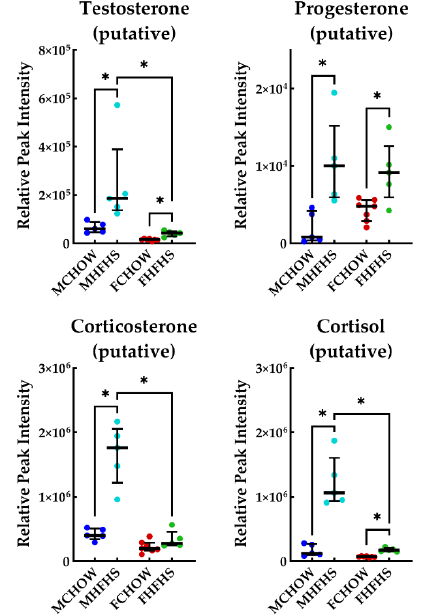
Figure 5. Androgen and Steroid Hormone Related Metabolites. Horizontal bars represent the median relative peak intensity of each metabolite with the interquartile range. * p < 0.01. MCHOW vs. FCHOW, MCHOW vs. FHFHS, and MHFHS vs. FHFHS groups were not compared.